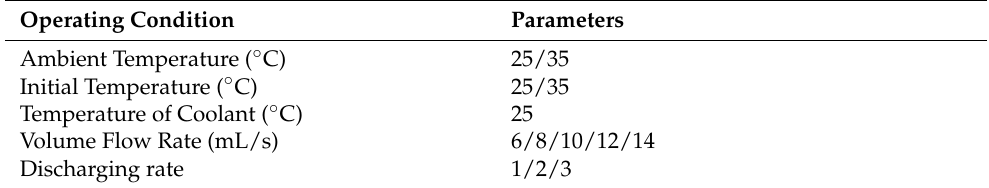
Table 4. The parameters of the operating conditions in the CSG module.